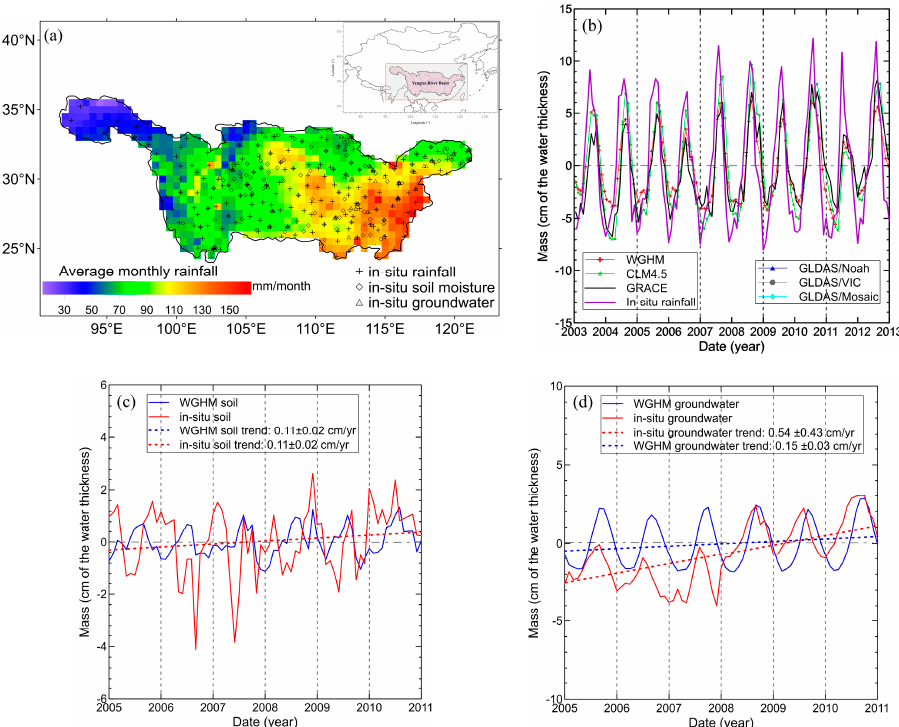
Figure 6. ( a ) Average monthly rainfall (in mm/month) in China based on in-situ observations for 2003–2012 from the CMDSSS. ( b ) Changes in the Yangtze River Basin (YRB) water storage (units: cm) from GRACE, GLDAS (Noah, VIC and Mosaic), WaterGAP Global Hydrology Model (WGHM), and version 4.5 of the Community Land Model (CLM4.5) models after Gaussian smoothing and applying the averaging kernel, and the time series of monthly in-situ rainfall (after removed mean value refer to YRB) from China Meteorological Data Sharing Service System (CMDSSS) for the selected area. ( c ) Times series of monthly in-situ observation of soil moisture (units: cm) from 122 sites located in YRB and soil moisture from WGHM outputs from 2005 to 2010. ( d ) Times series of monthly in-situ observation of groundwater (units: cm) from 136 sites located in YRB and groundwater from WGHM outputs from 2005 to 2010. ( c , d ) both removed mean value refer to the YRB, cm/yr represents cm per year, in-situ observation of soil moisture data also provided by CMDSSS and in-situ observation of groundwater data (available only from 2005 to 2010) are obtained from the groundwater level yearbook compiled by the Institute of China Geological Environment Monitoring [41].